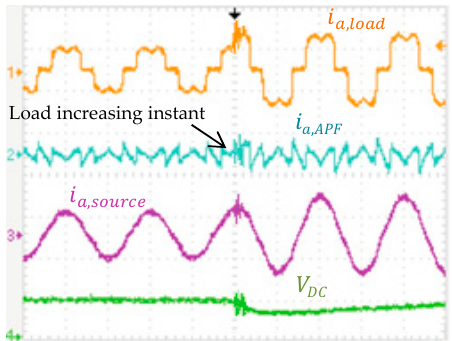
Figure 10. Experimental results at load variation condition; ( the orange color ) the load current wave form of phase A [Amp/div: 6 A and time/div: 10 ms], ( the blue color ) the APF current wave form of phase A [Amp/div: 6 A and time/div: 10 ms], ( the pink color ) the source current wave form of phase A [Amp/div: 6 A and time/div: 10 ms], ( the green color ) the DC link voltage [volt/div: 500 V and time/div: 10 ms].